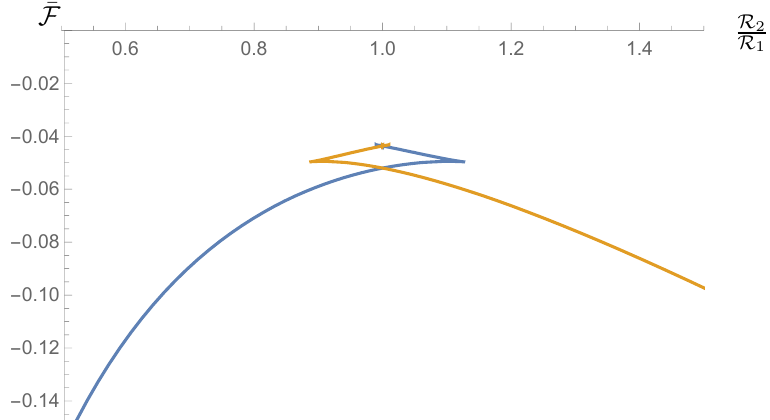
Figure 9 . Finite part (cid:22) F of the free energy (E.43) as a function of the ratio R 2 = R 1 , in both the case where the sphere 1 shrinks (blue) and the case where the sphere 2 shrinks (orange). We normalize by the overall volume factor 32 (cid:25) 2 M 3 ‘ 3 . The point where the two curves (cid:12)rst cross at R 1 = R 2 p corresponds to a bifurcation, where the sphere that shrinks is exchanged and the vev changes sign.